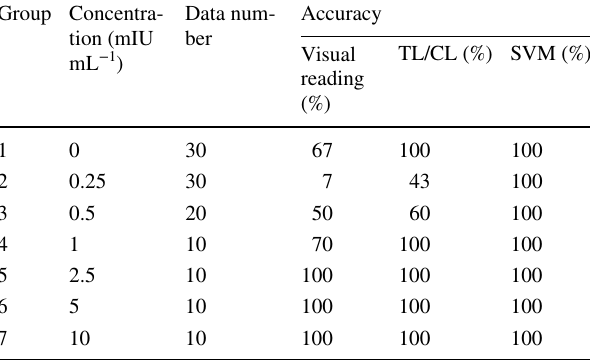
Table 1 Qualitative results using visual reading, semiquantitative detection, and SVM classifier Group Concentra- tion